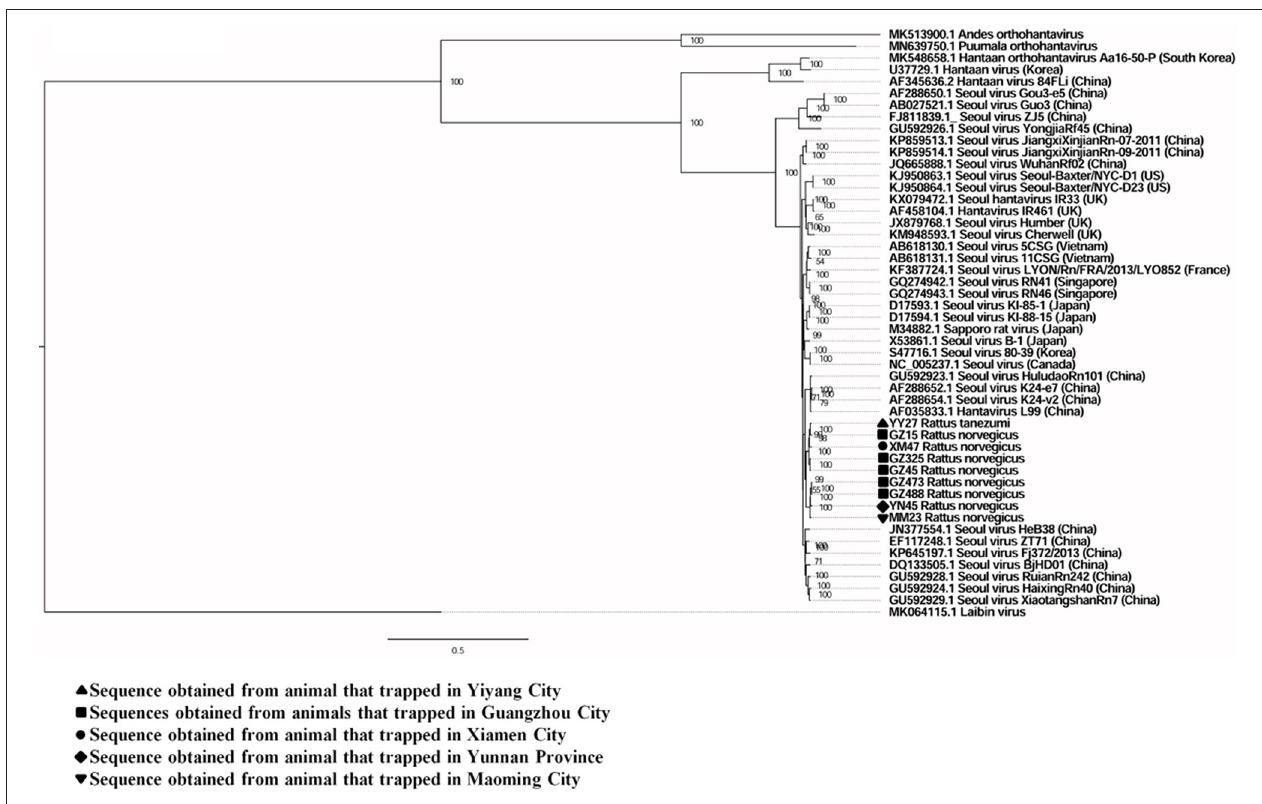
FIGURE 4 | Phylogenetic tree constructed using nucleotide sequences of the Seoul virus M gene obtained from rats. Forty representative orthohantavirus sequences were included for comparison, and one Laibin virus sequence was set as the outgroup. The percentages of the posterior probability (PP) values are indicated.